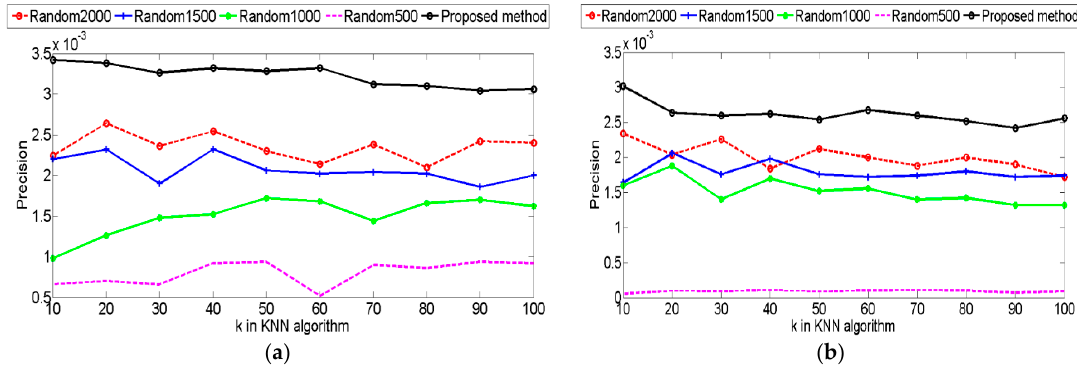
Figure 6. ( a ) Precision criterion with similarity measures of cosine; ( b ) Precision criterion with similarity measures of NHSM.